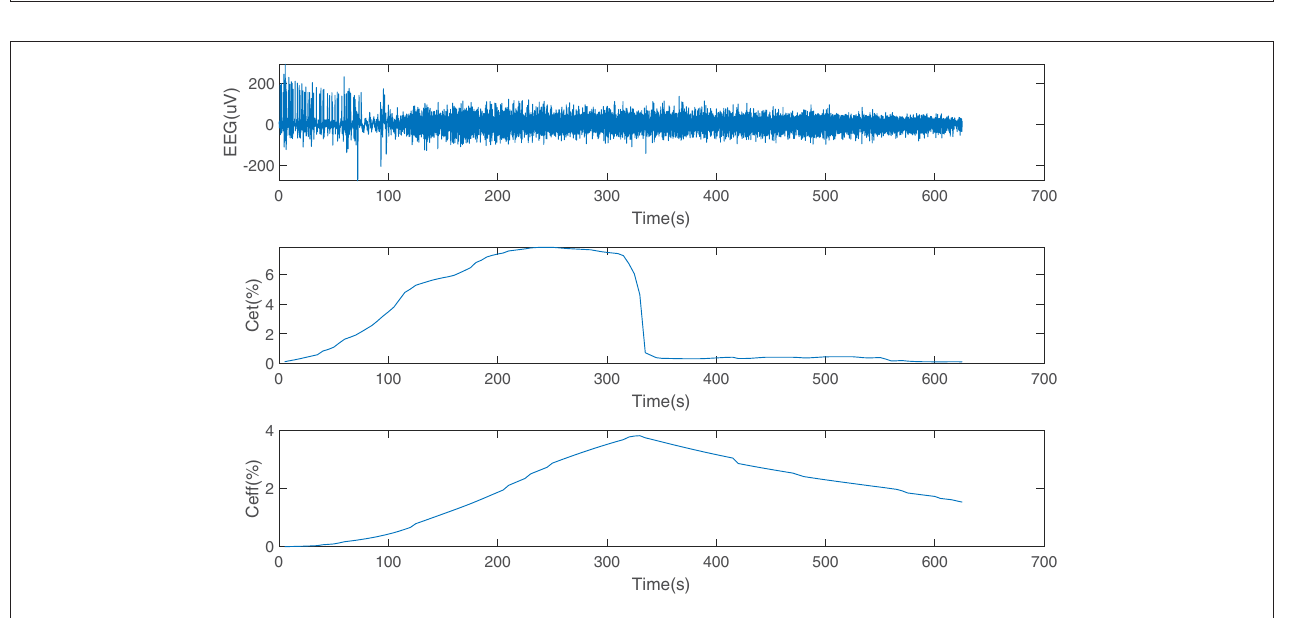
FIGURE 5 | Depiction of our proposed framework. The structure of SDAE-LSTM is a contracted form, which means that 46 features are input in the SDAE-LSTM network, and there is output one index with which to monitor the DoA. The details of the SDAE-LSTM structure can be seen in Figure 4 .